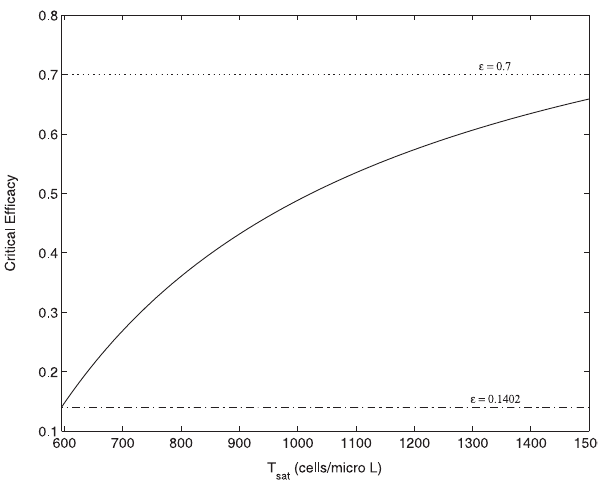
Figure 5. Dependency of the Critical Drug Efficacy on the Concentration of T cells T sat represents the concentration that T cells approach as the duration of ART increases. The solid line shows how the critical efficacy depends on T sat . The dotted line indicates a typical drug efficacy estimated for standard combination ART ( e ’ 0.7), and the dashdot line indicates the critical efficacy when T sat ¼ T 0 ¼ 595 cells/ l l, i.e., e c ¼ 0.1402. DOI: